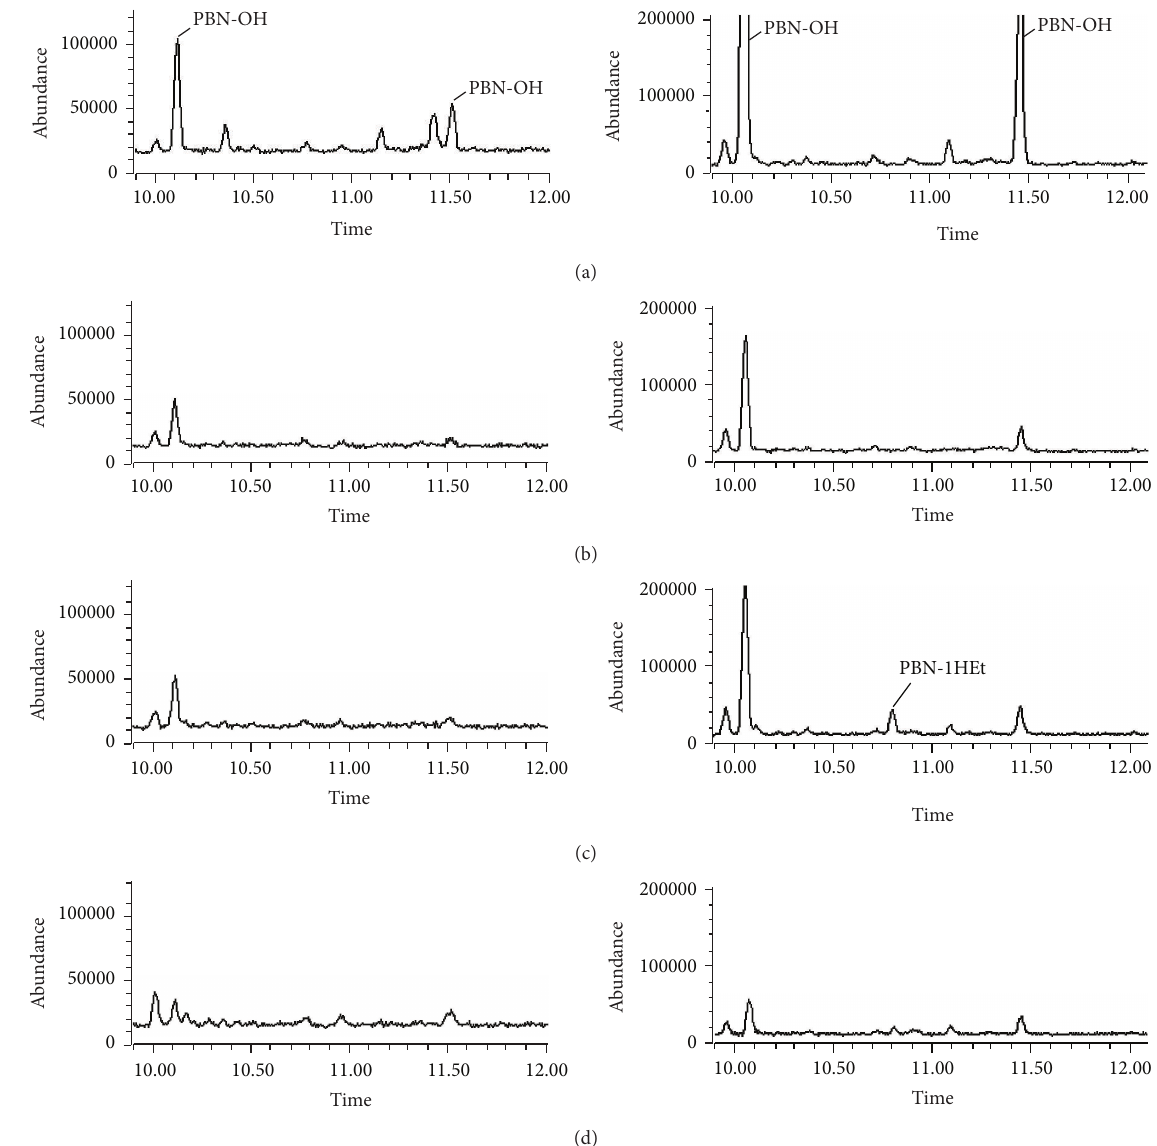
Figure 2: Selected-ion current profile obtained from GC-MS-SIM analysis of a sample from incubation containing microsomal fraction and ethanol, in the presence of the spin trap PBN, after trimethylsilylation. Left: uterine horn microsomes. Right: liver microsomes. (a) Microsomes + NADPH generating system. (b) Microsomes only. (c) Microsomes + NADPH generating system + ethanol. (d) Microsomes +